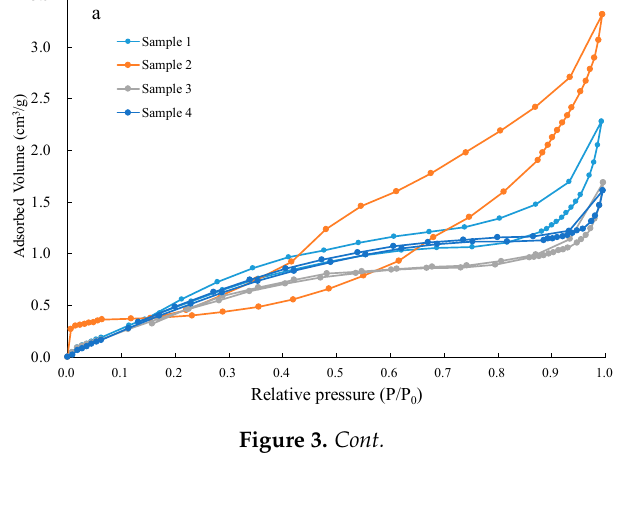
Table 1. The mineral composition and geochemical characteristics of the Bakken samples.